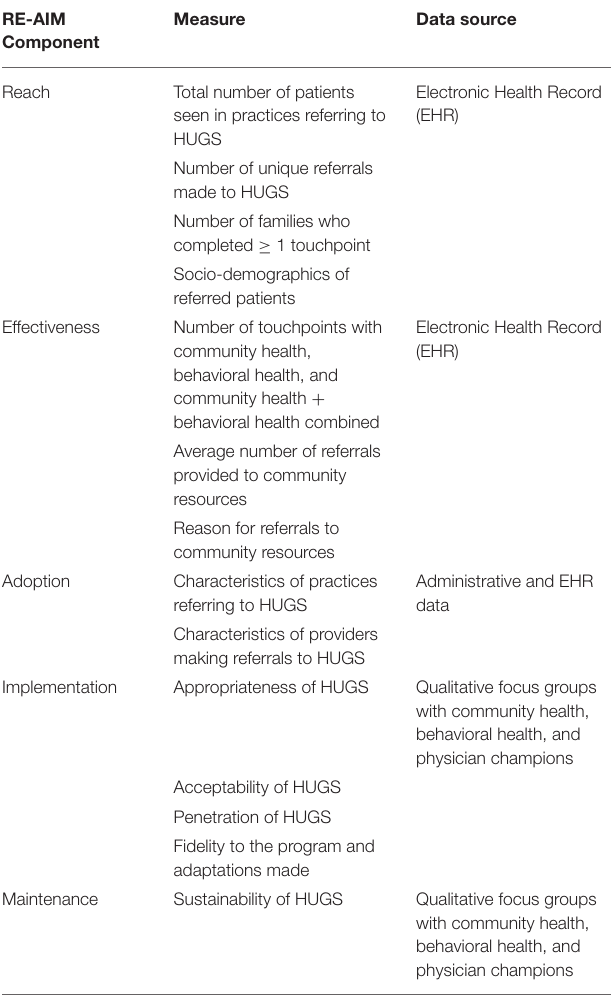
TABLE 1 | Evaluation of the HUGS/Abrazos program using the RE-AIM framework. RE-AIM